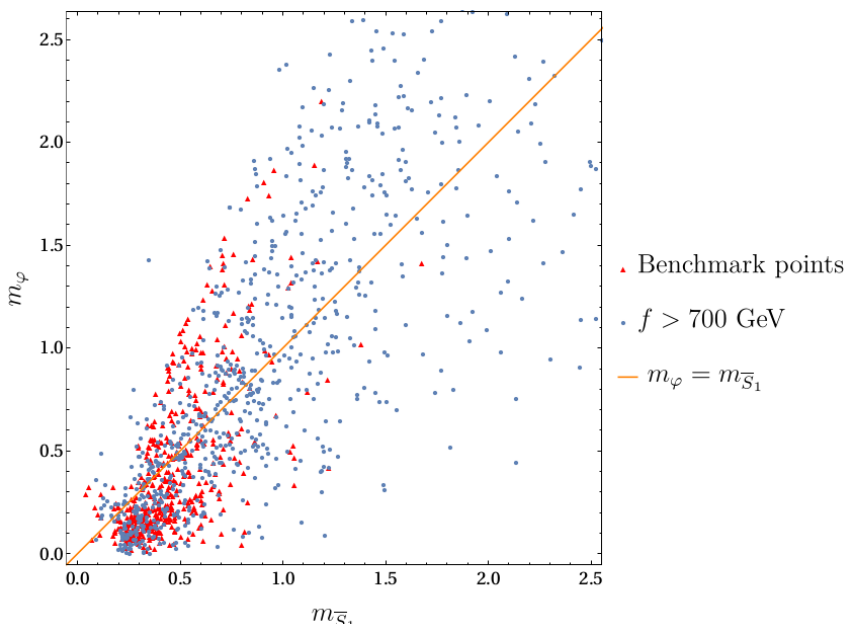
Figure 3 . Scatter plot of the ’ particle mass as a function of the mass of the scalar LQ. Plotted in blue are points with f > 700 GeV and in red the ones inside the benchmark window. Also included is the line m ’ = m (cid:22) S 1